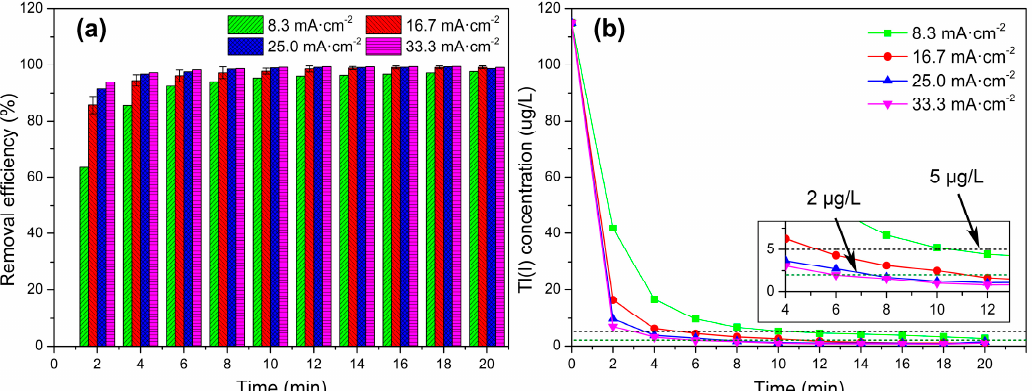
Figure 5. Effect of current density on ( a ) removal efficiency, ( b ) concentration of Tl(I) within 20 min EC treatment under initial pH of 11 ± 0.1, using Fe–Fe electrodes at a distance of 2 cm. Aeration of 0.2 L/min. C 0 = 115 µg/L.